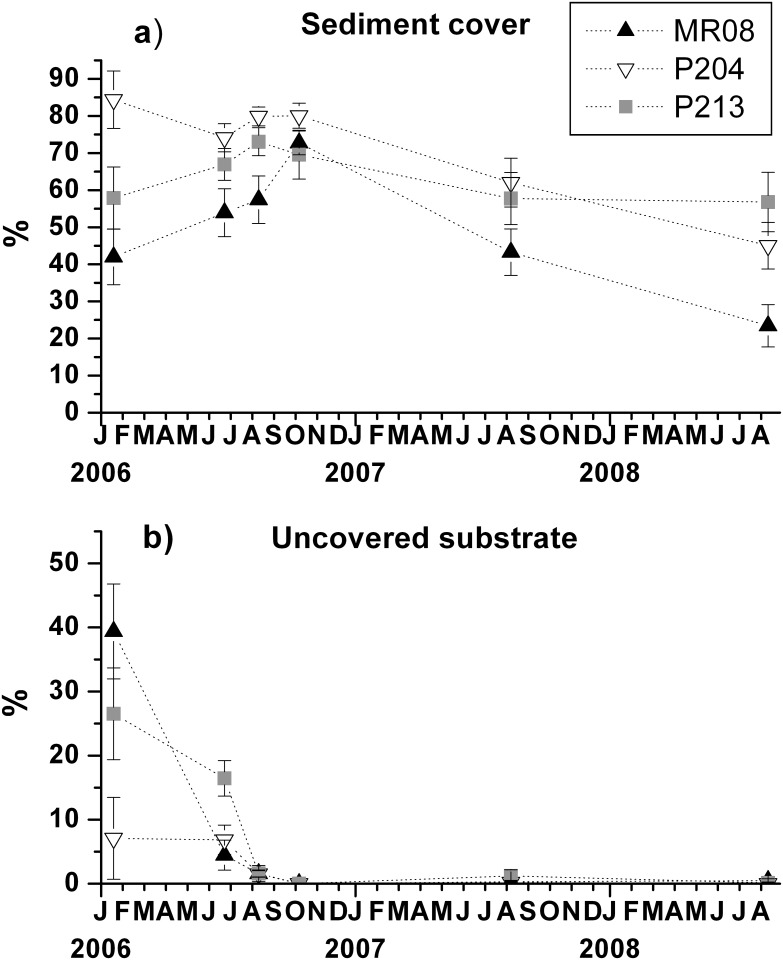
Temporal trends of occupation of space on experimental tiles.Temporal trends of (a) sediment percent cover and (b) proportion of substrate uncovered neither by sediments nor by organisms at each site (mean ± SE).